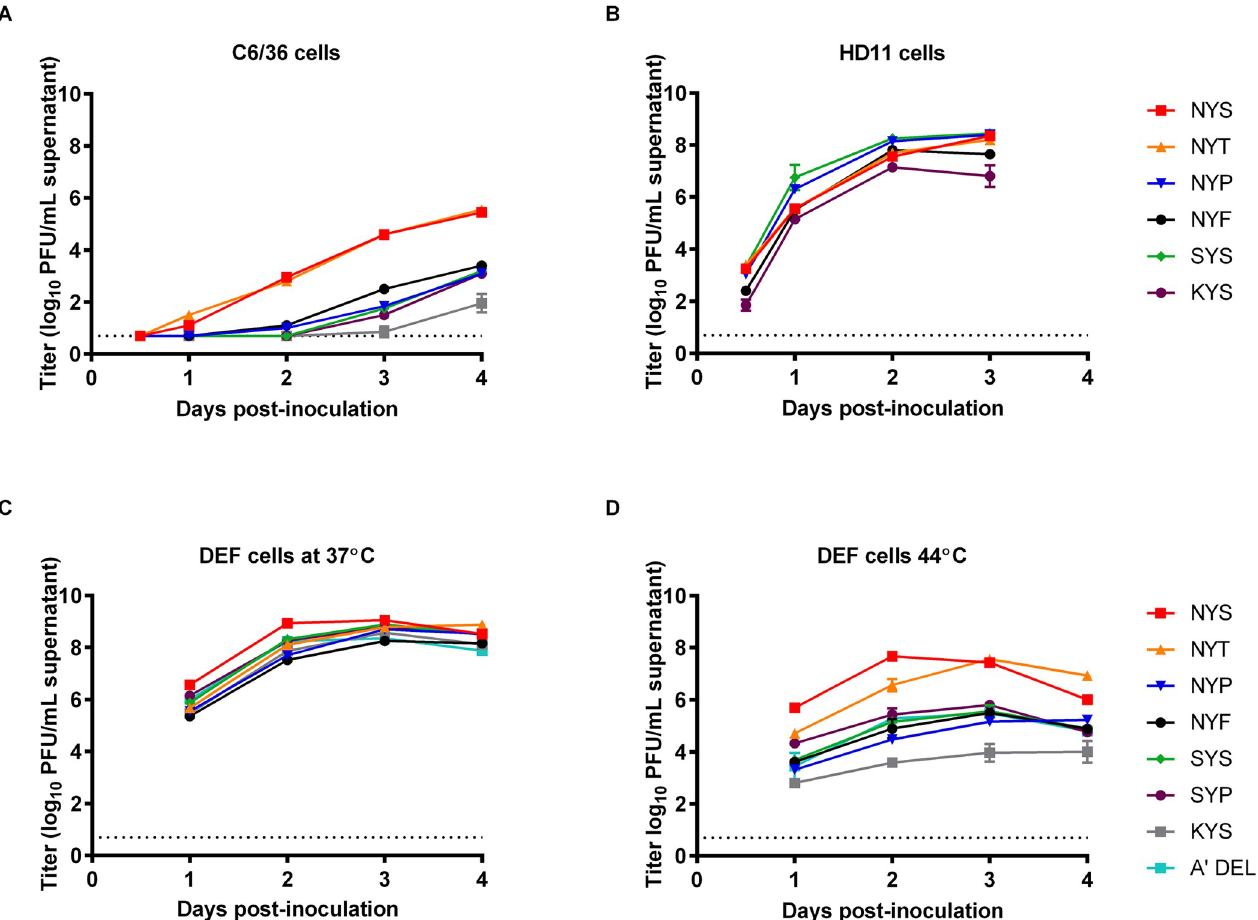
Fig 2. Virus growth of parental and WNV glycosylation mutant viruses. (A) mosquito cells (C6/36) (B) HD11 cells (C) DEF cells at 37˚C and (D) DEF cells at 44˚C inoculated at an MOI of 0. 1. Supernatants were collected at 12, 24, 48, 72 and 96 hpi (C6/36 and HD11 cells) and 24, 48, 72 and 96 hpi (DEF cells), diluted 1:10 and stored until titration using a standard plaque assay. Viral titers were reported in log 10 PFU/mL and plotted against hours post-inoculation. Viral titers were statistically analyzed via a one-way ANOVA and asterisks represent significant differences with a p-value of < 0.05. LODs are shown by dashed